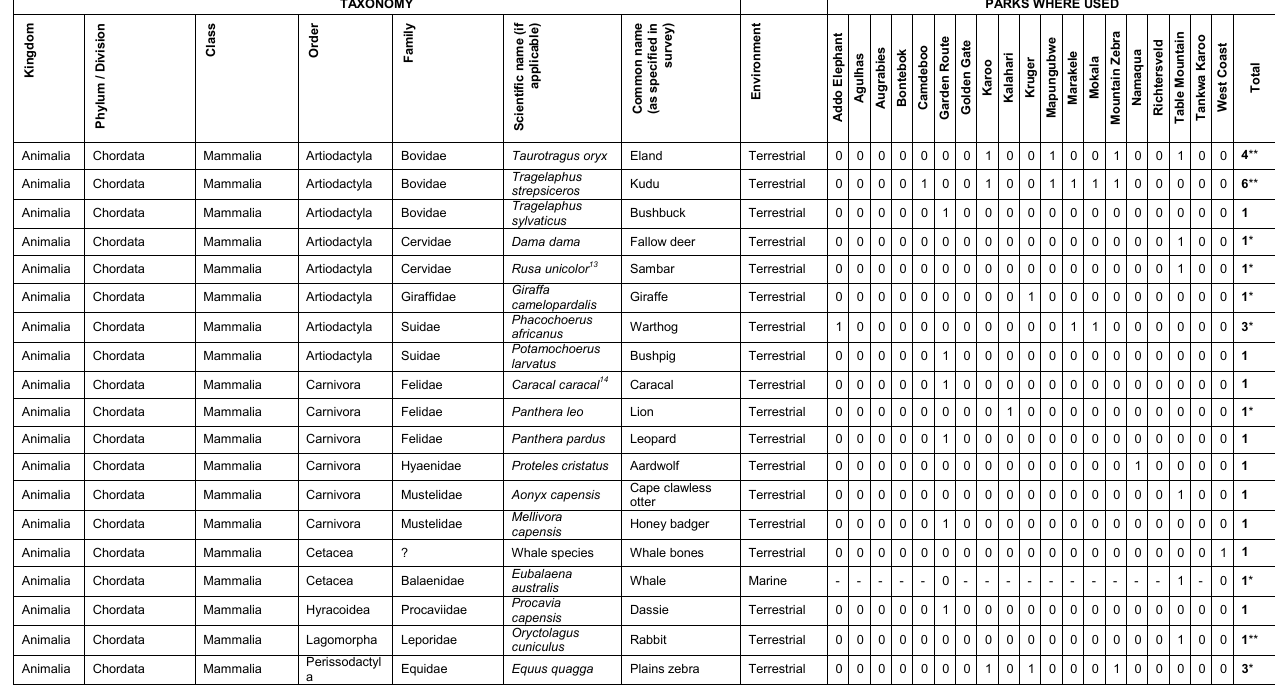
TAXONOMY PARKS WHERE USED